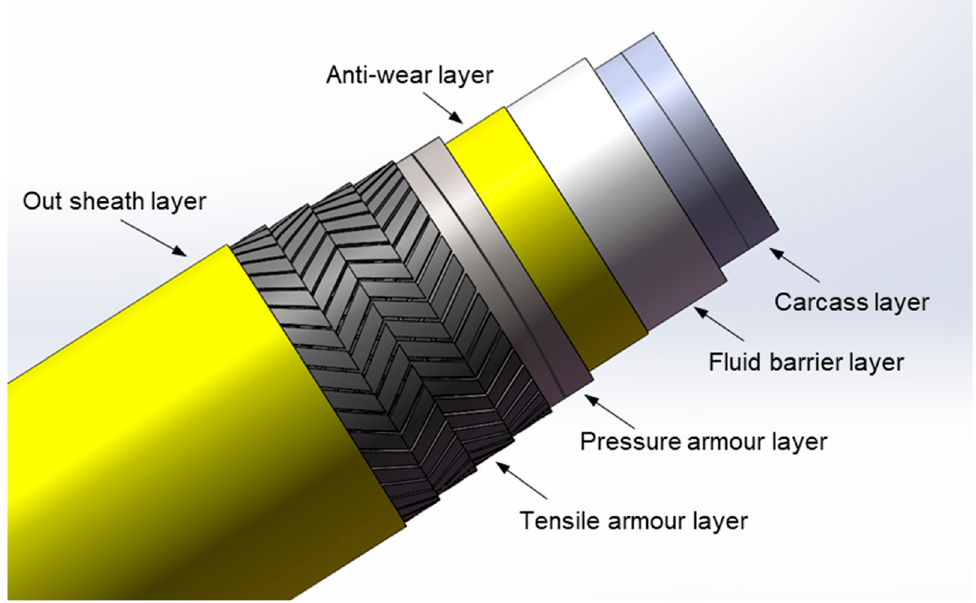
Figure 1. The structure of typical unbonded flexible riser.